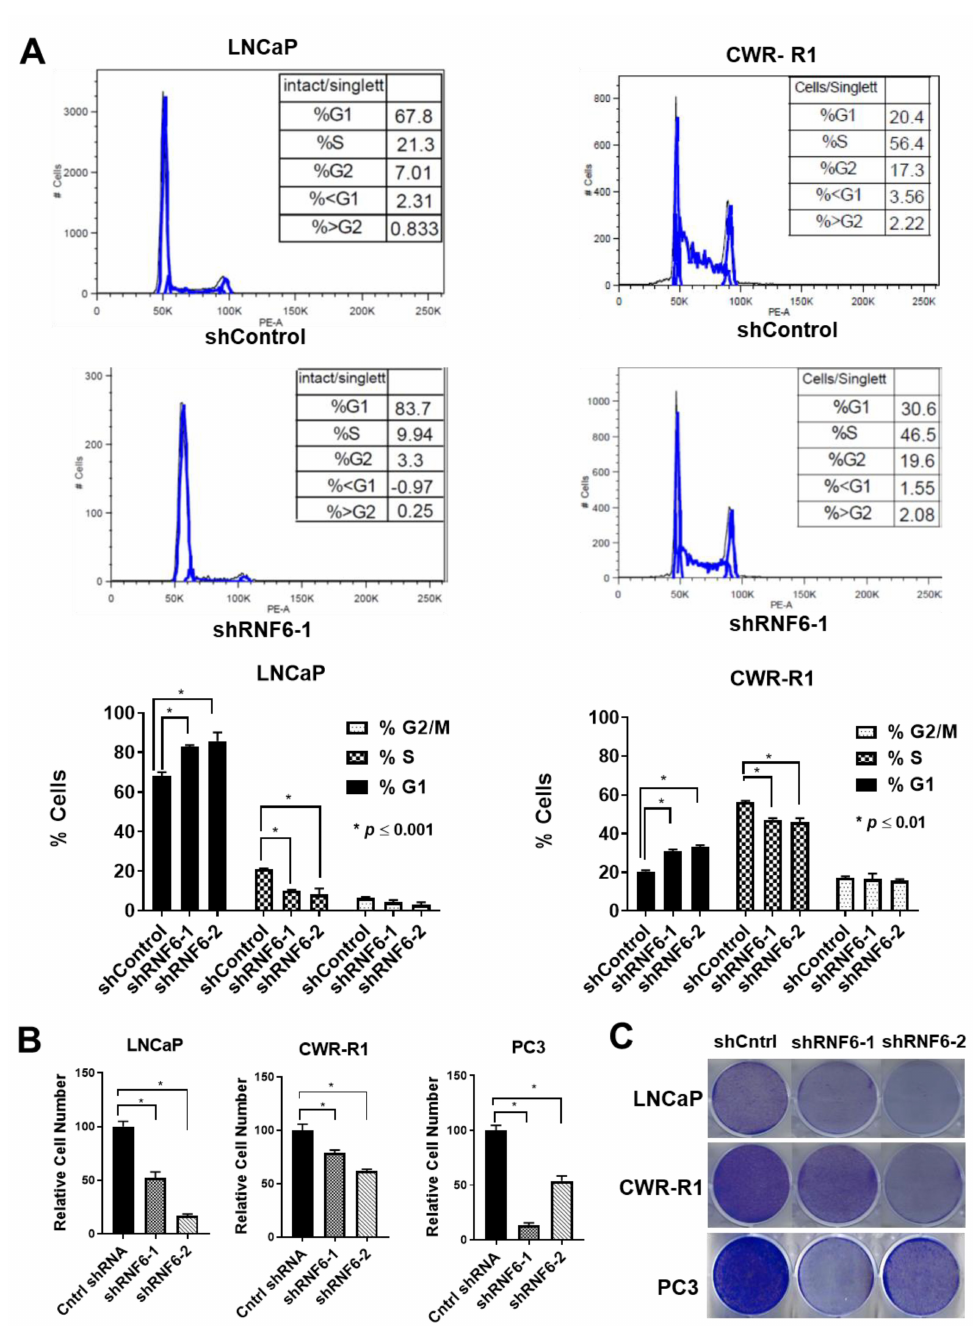
Figure 6. Knockdown of RNF6 leads to G1/S block and to reduced cell proliferation. ( A ) Asyn- chronous cells were transduced with either control shRNA or shRNF6 for 72 h after which they were stained with PI as described in materials and methods. After PI staining, cells were subjected to FACS analysis. ( B ) Cells were transduced with either control shRNA or RNF6 shRNA for 7 days. Cell proliferation was then assessed using CCK8 assay, * p < 0.05. ( C ) Cells were transduced with control or RNF6 shRNA as in B. Cells were then fixed and stained with Coomassie blue